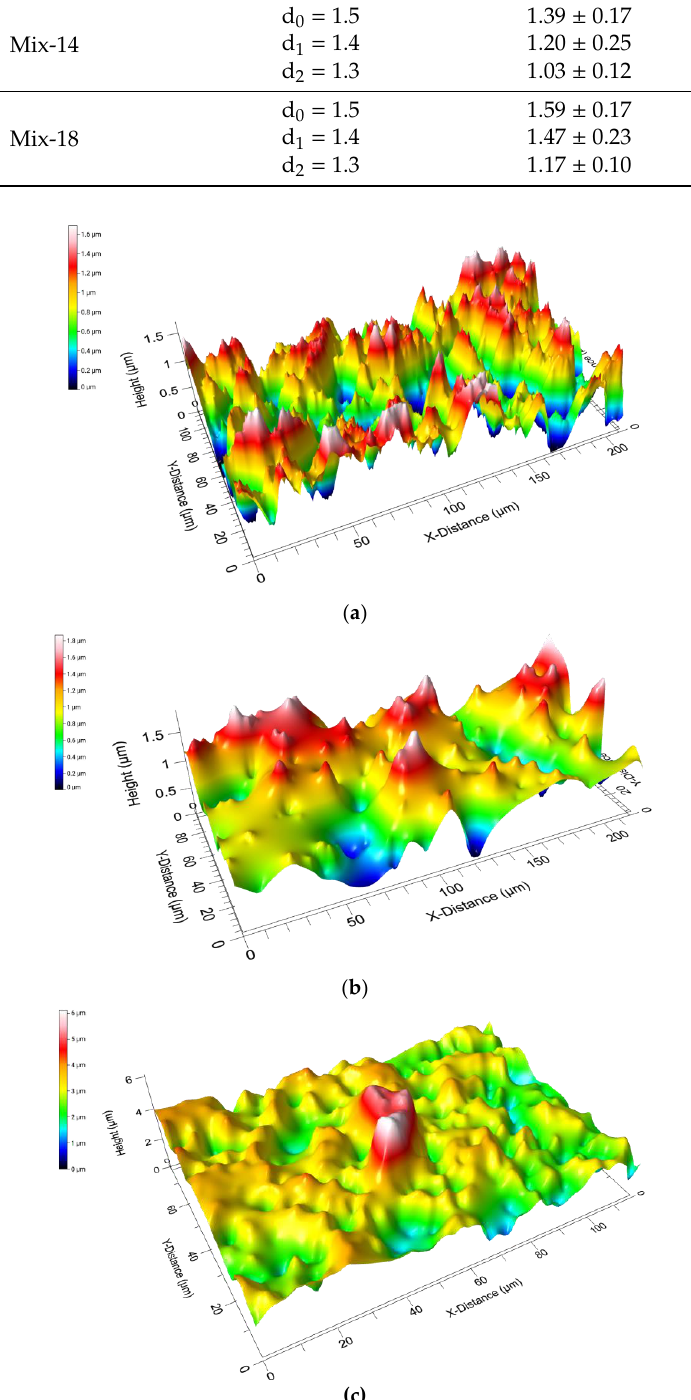
Figure 3. 3-D images of the surface roughness of unrestricted (control or d 0 = 1.5 cm) aerogels. ( a ) 3-D image of the SSMPA Mix-14 and ( b ) 3-D image of the SSMPA Mix-18. ( c ) 3-D image of SSMPA and PC12 cell growing on the aerogel. The color scale bar represents the Z axis throughout the surface of the